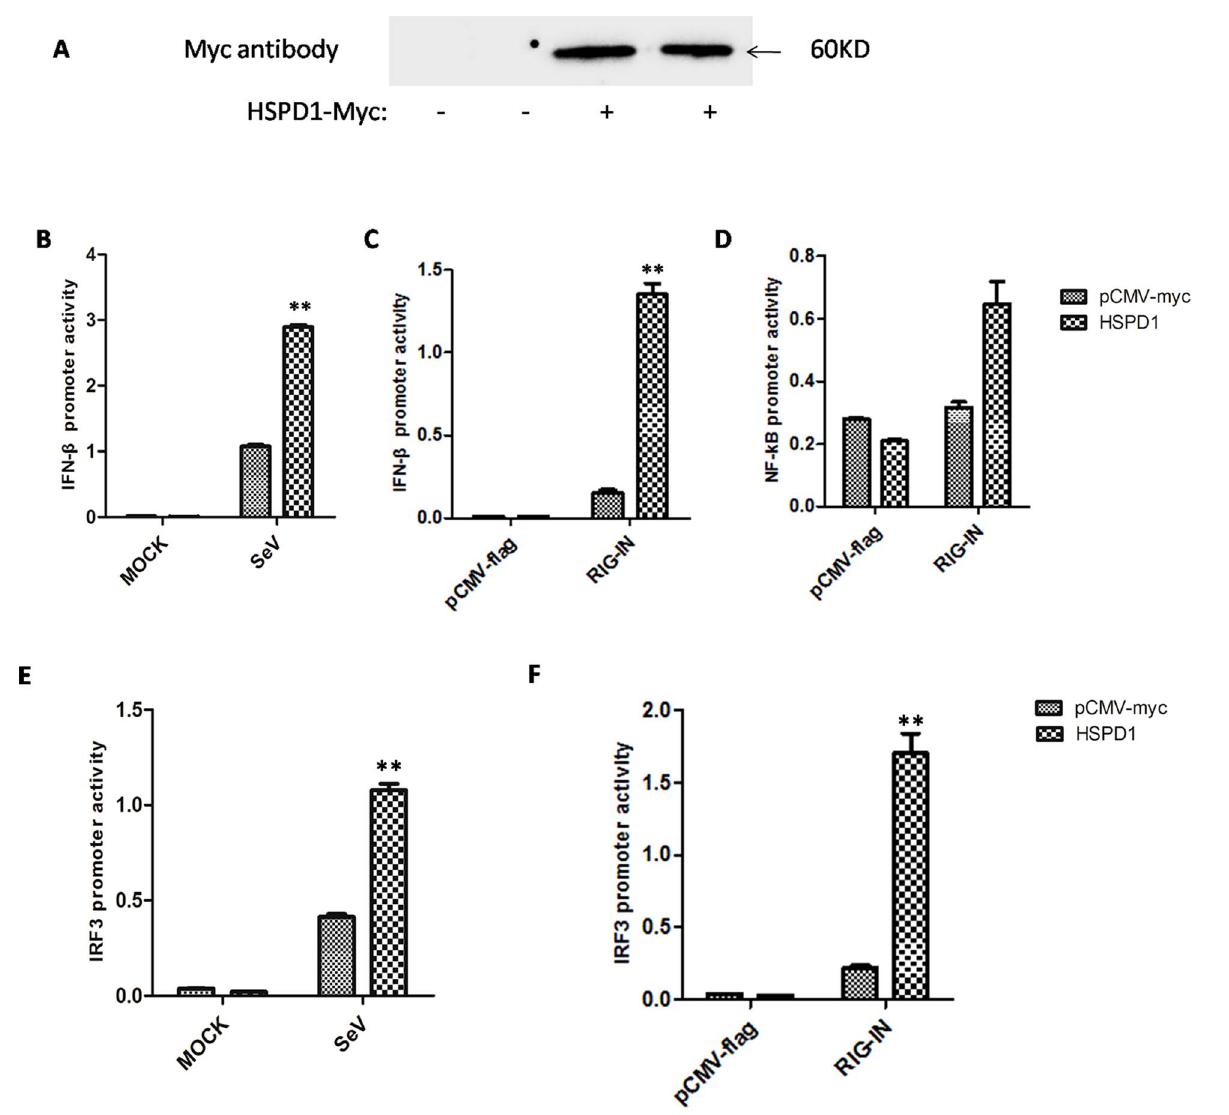
Fig. 3. Overexpression of HSPD1 facilitated IFN- b induction. A. The expression of Myc-tagged HSPD1 was detected using an antibody against the Myc tag. B and E. The HEK293Tcells were co-transfected with the luciferase reporter plasmid pIFN- b -Luc or pIRF3-Luc, the Renilla luciferase plasmid phRL-TK and plasmid encoding Myc-tagged HSPD1 or control vector. After incubation for 24 h, the cells were infected with SeV or mock-treated with the same buffer. After infection for 8 h, all of the cells were collected and the luciferase activity was measured using a dual-luciferase assay system. Data represent the relative firefly luciferase activity normalized to the Renilla luciferase activity. C and F. The HEK293Tcells were co-transfected with 200 ng of the luciferase reporter plasmid pIFN- b -Luc or pIRF3-Luc, 20 ng of the Renilla luciferase plasmid phRL-TK (Promega), 200 ng of plasmid encoding Myc-tagged HSPD1 or control vector, and 200 ng of plasmid encoding RIG-IN or control vector for 36 h. The cells were then collected, and the luciferase activity was measured using a dual-luciferase assay system (Promega) and a luminometer (Turner BioSystems, CA). D. The HEK293Tcells were co-transfected with 200 ng of the luciferase reporter plasmid p NF- k B -Luc or pIRF3-Luc, 20 ng of the Renilla luciferase plasmid phRL-TK (Promega), 400 ng of plasmid encoding Myc- tagged HSPD1 or control vector. After incubation for 24 h, the cells were infected with SeV or mock-treated with the same buffer. After infection for 8 h, all of the cells were collected and the luciferase activity was measured using a dual-luciferase assay